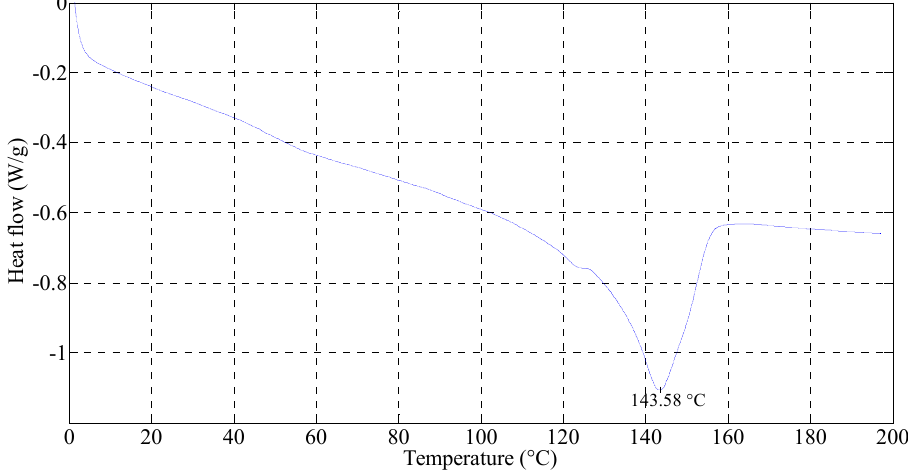
Figure 1. A differential scanning calorimetry curve of neat PP.